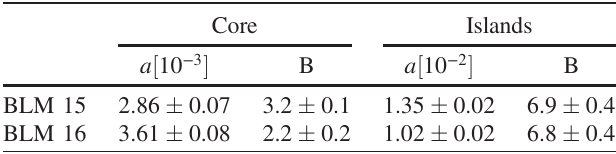
þ b , where N is the total intensity, best fitting the data p b plotted in Fig. 11. Results for the core and the islands are